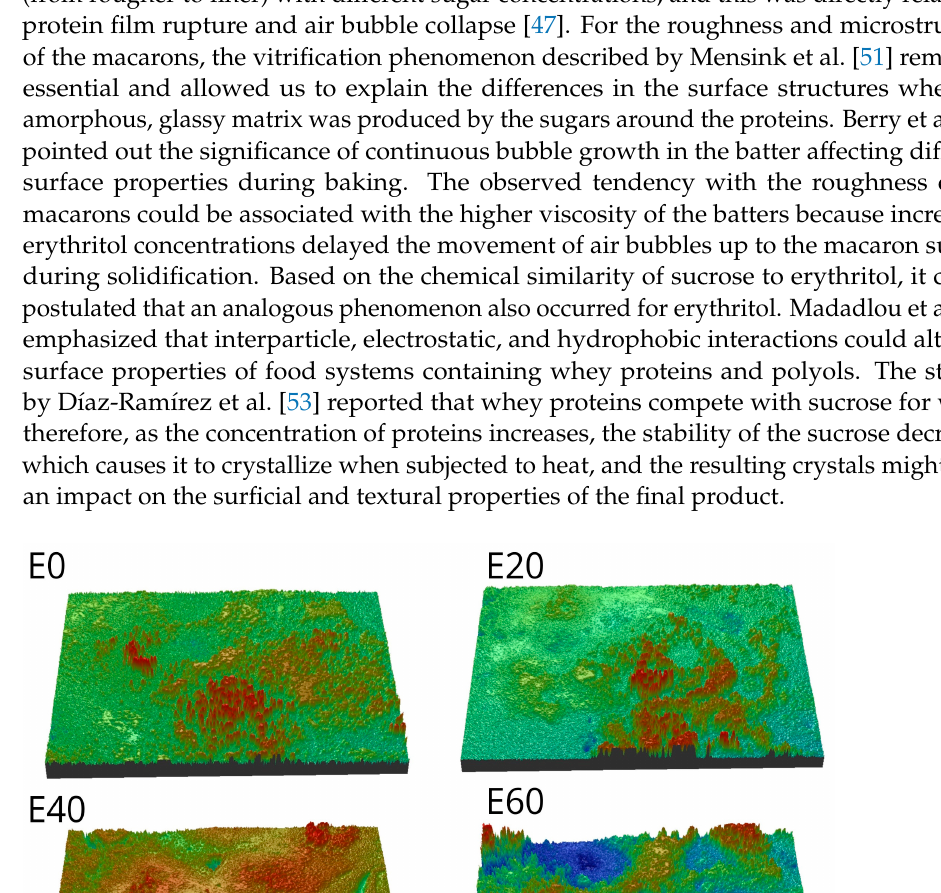
Table 3. The surface roughness parameters and the color co-ordinates of the obtained macarons. R a —the average roughness, R q —the quadratic mean of surface roughness, R t —the maximum rough- ness height, L*—the brightness, a*: ± red-green, and b*: yellow-blue.